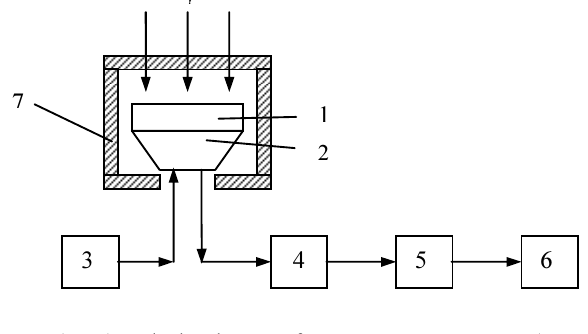
Fig. 1. Block-scheme of gamma-spectrometer: 1 – scintillation detector NaI(Tl); 2 – photomultiplier; 3 – high-voltage stabiliser; 4 – linear amplifier; 5 – impulse analyser; 6 – registration device (computer); 7 – lead pro-